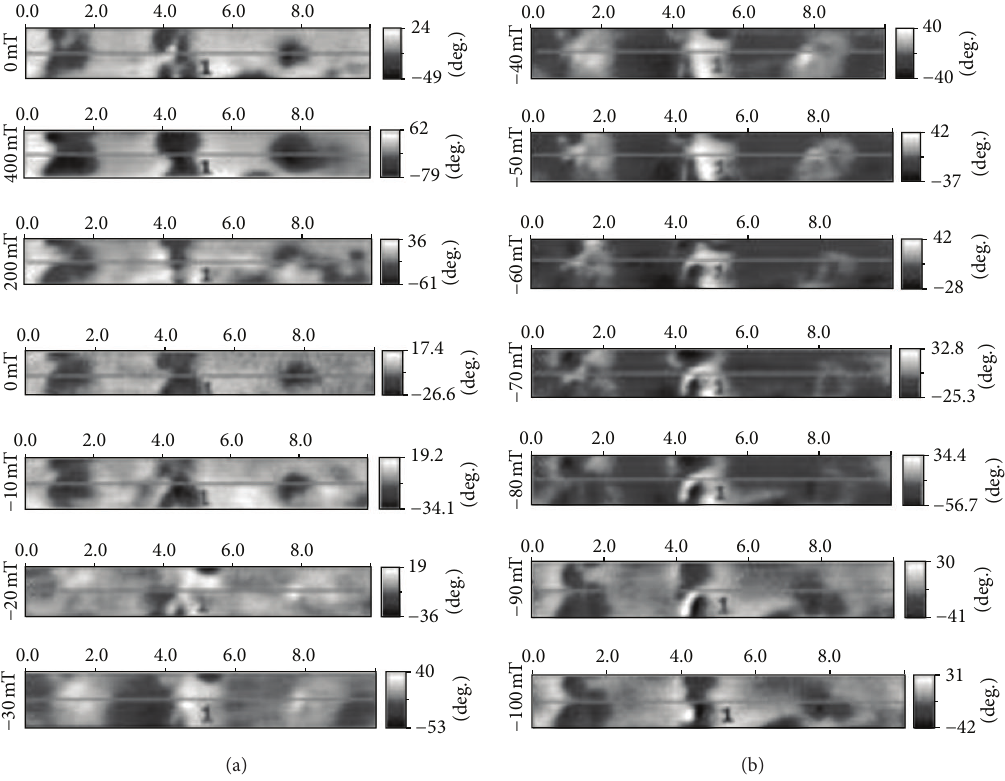
Figure 5: MFM images of magnetization switching of three neighbor agglomerates on surface of the Fe25 glass. The horizontal scales are in 𝜇 m. The vertical scales (in degrees) values of phase at measurement of magnetic response in MFM mode.